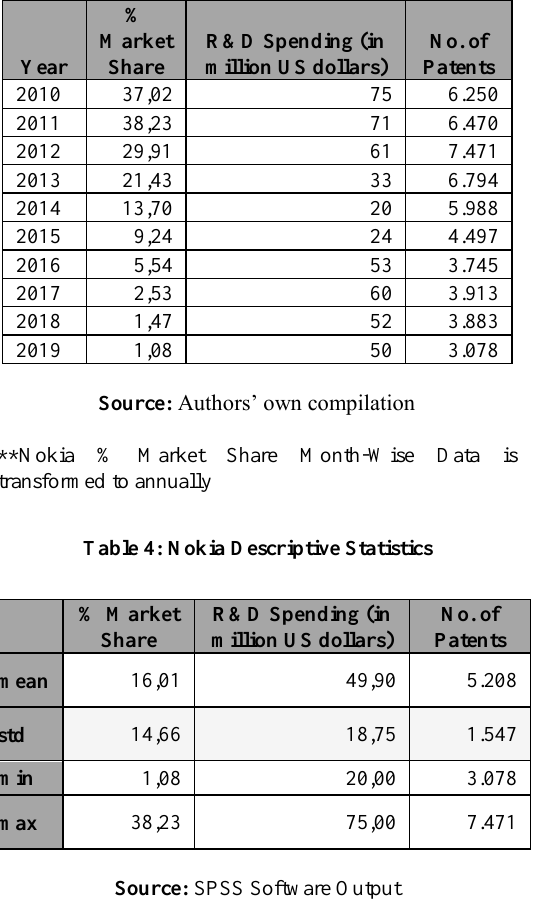
Table 3: Nokia Ten Years Data (2010-2019)